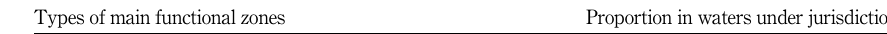
Table 1. Marinemainfunctional areas of Shandong